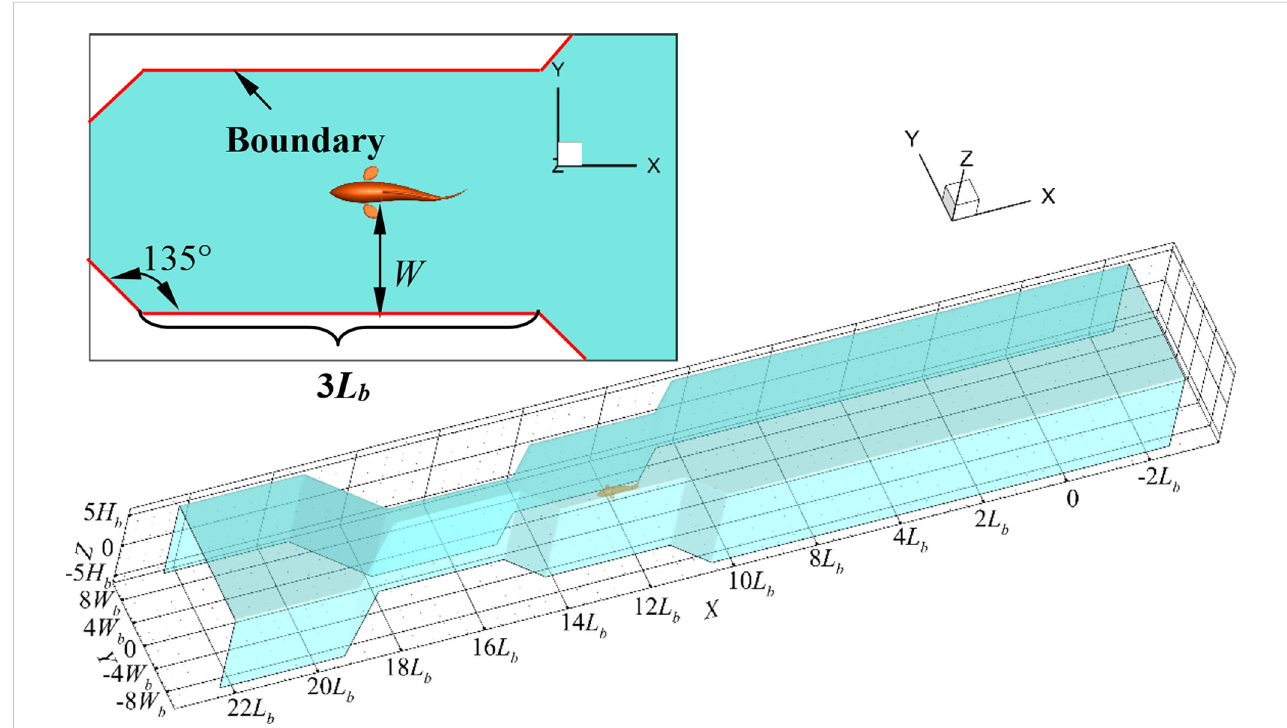
FIGURE 4 The narrow-channel boundary